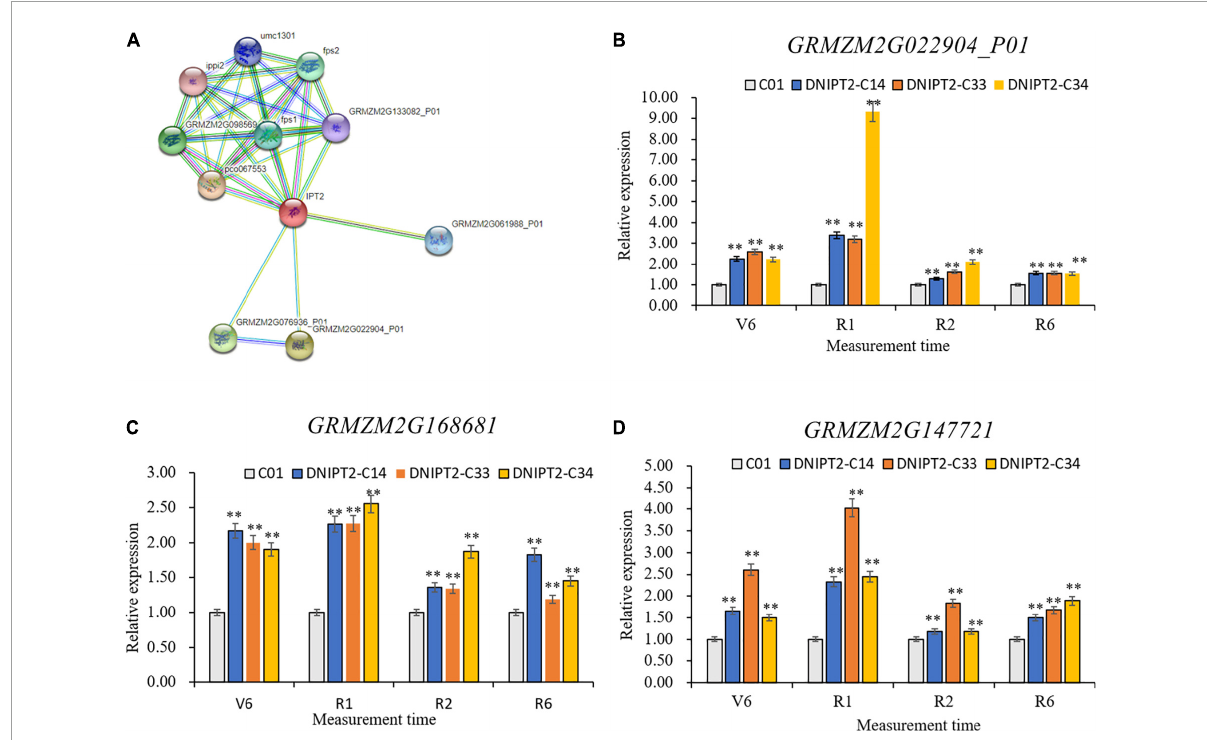
FIGURE5 Gene analysis of ZmIPT2 interaction. (A) The predictive and analysis of ZmIPT2 interaction protein. (B) Relative expression levels of transgenic GRMZM2G022904_P01 gene in maize leaves at different stages. (C) Relative expression levels of transgenic GRMZM2G168681 gene in maize leaves at different stages. (D) Relative expression levels of transgenic GRMZM2G147721 gene in maize leaves at different stages. There was significant difference or extremely significant difference in the expression level (** P < 0.01, Student t